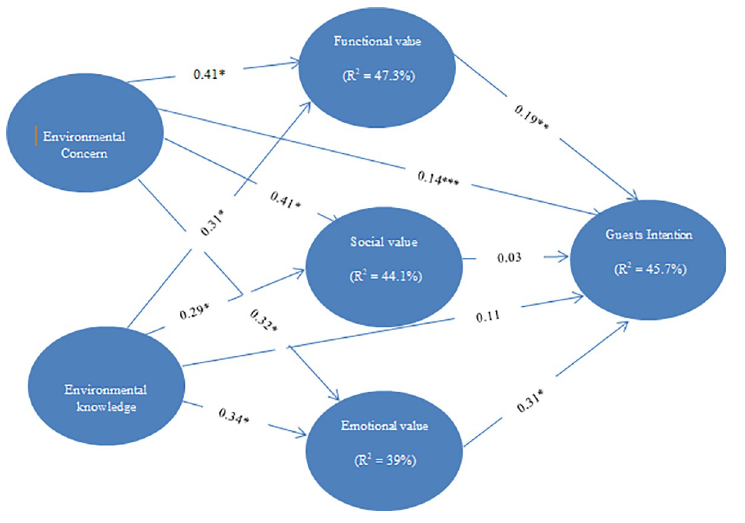
Fig 1. Structural model